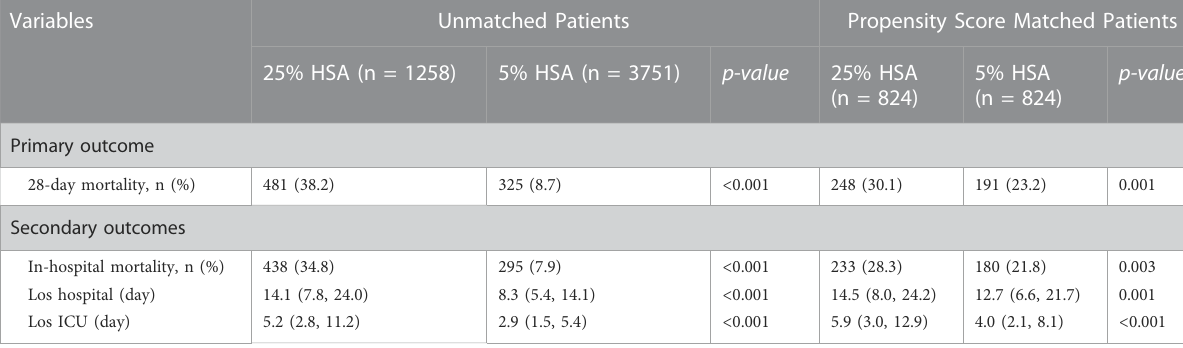
TABLE 2 Study endpoints of 25%HSA and 5% HSA groups before and after propensity score matching. Variables